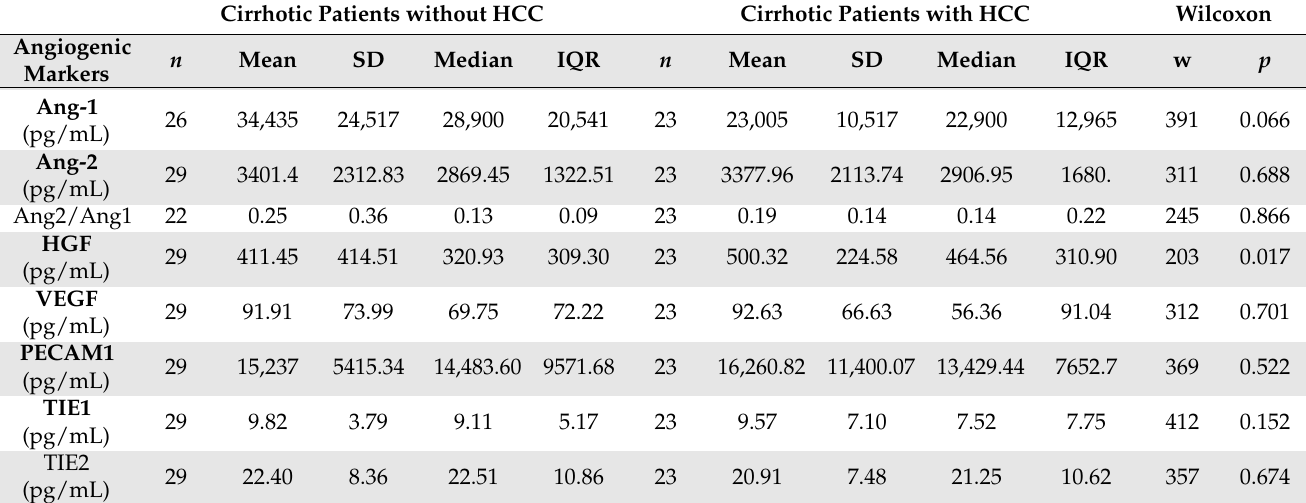
Table 2. Comparison of selected angiogenic markers between cirrhotic patients and cirrhotic patients with HCC.